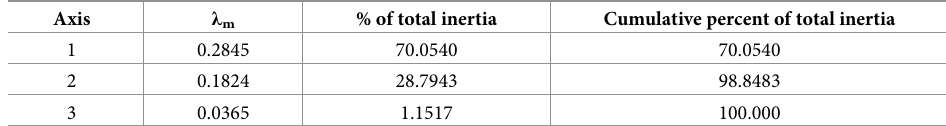
Table 4. Inertia decomposition of Utility and Efficacy